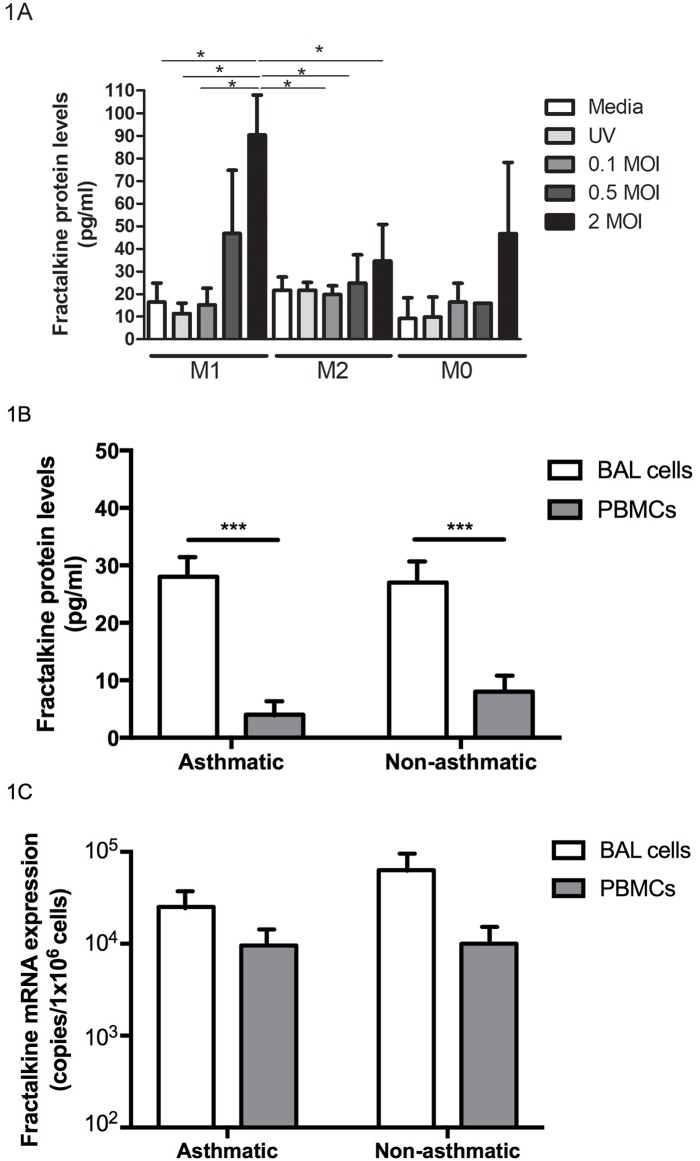
Fractalkine expression in vitro by BAL cells, PBMCs and RV16-infected macrophages.A) Soluble fractalkine protein was measured in cell supernatants from human peripheral blood monocyte-derived macrophages (M0) and M1 and M2 polarized macrophages (n = 3) following in vitro RV16 infection (0.1–2 MOI) or control conditions (Media, UK-inactivated RV16). B) Soluble fractalkine protein was measured in PBMC (grey columns) and BAL (white columns) cell supernatants obtained from asthmatic (n = 15) and non-asthmatic (n = 15) subjects following 8h incubation in RPMI medium. C) Gene expression (mRNA levels) was measured in cDNA from PBMC and BAL cells from each subject. All data are expressed as mean ± SEM. Data were analysed by one-way ANOVA with Bonferroni post-test (*P<0.05, ***P<0.001).